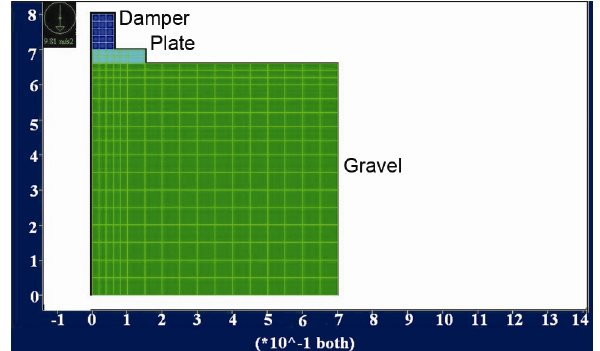
Fig. 2. Mesh generation for FLAC analysis